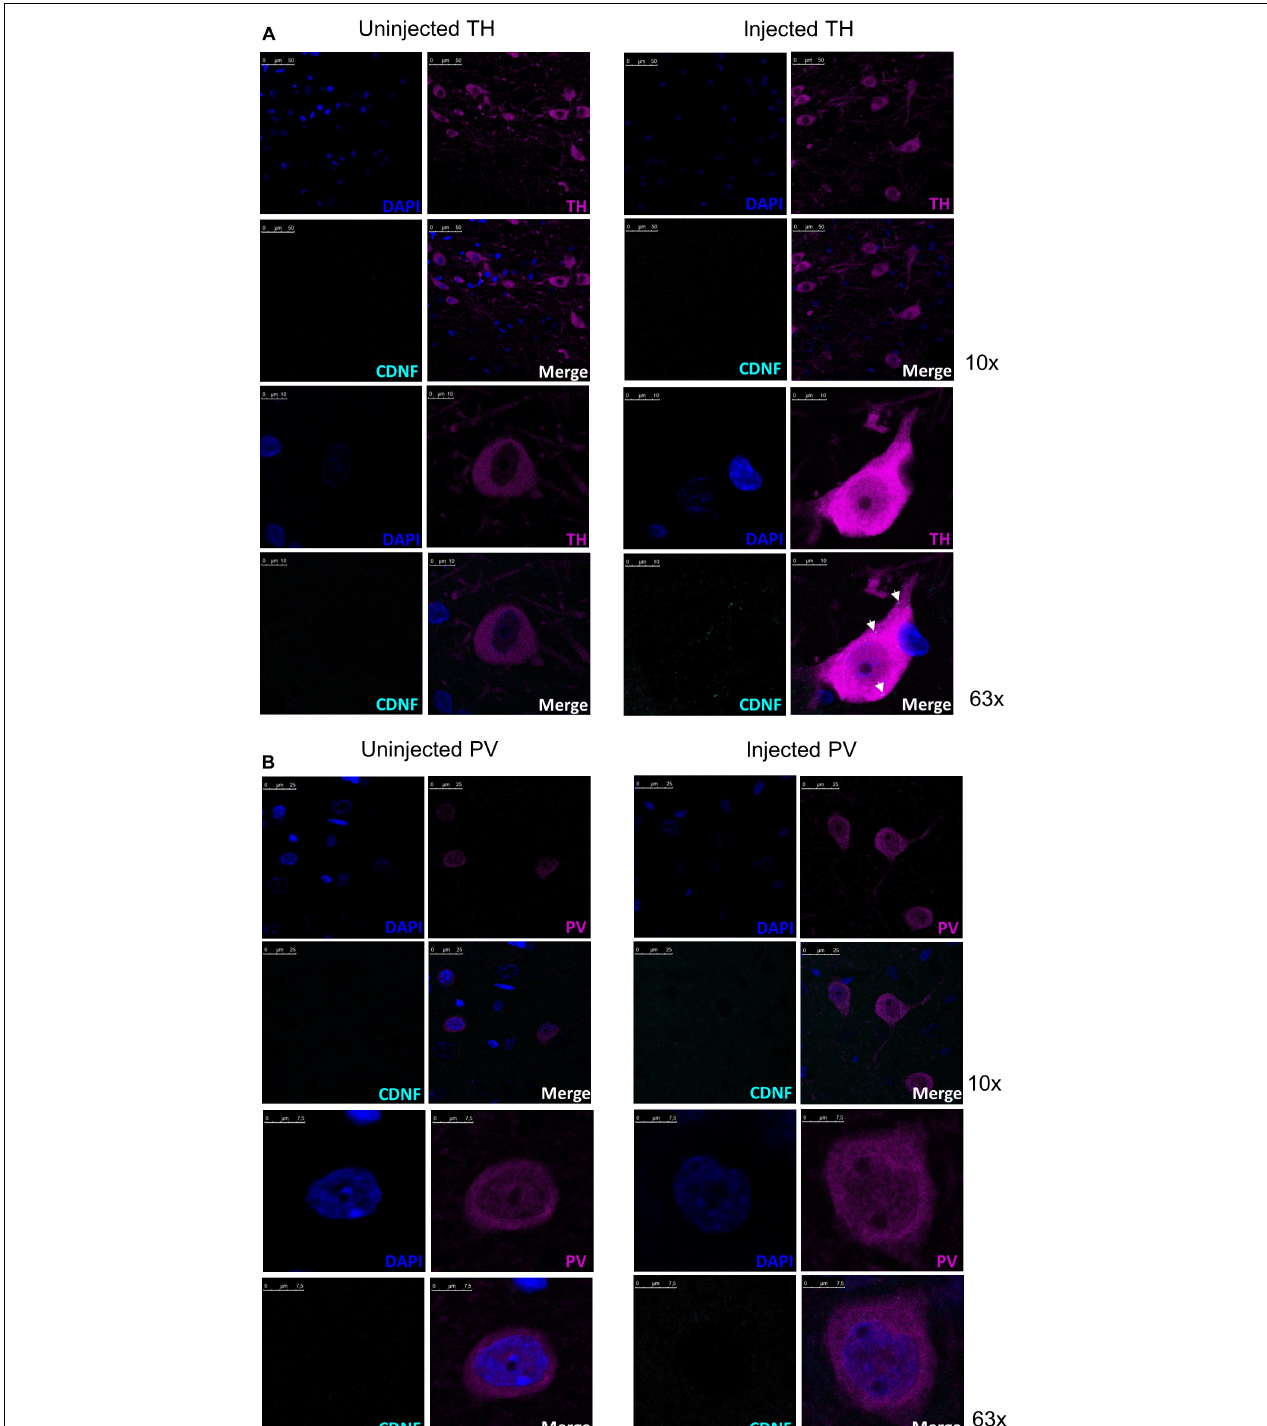
FIGURE 3 | Representative confocal images of CDNF-injected rat substantia nigra with tyrosine hydroxylase (TH) neurons or parvalbumin (PV) neurons to demonstrate colocalization. (A) Representative confocal images from a rat brain injected with human CDNF into the substantia nigra (SN) and perfused 2 h later with costaining for CDNF and TH. Total of six rats were injected and stained for the colocalization study. White arrows in the injected side indicate CDNF immunoreactive puncta (cyan dots). Uninjected side representative image taken with identical settings to account for possible background. Top panel 10 × objective, lower panel 63 × objective. (B) Representative confocal images from rats injected with human CDNF into the SN and perfused 2 h later with costaining for CDNF and PV. Uninjected side representive image taken with identical settings to account for possible background. Top panels 10 × objective, lower panels 63 × objective. N = 6.